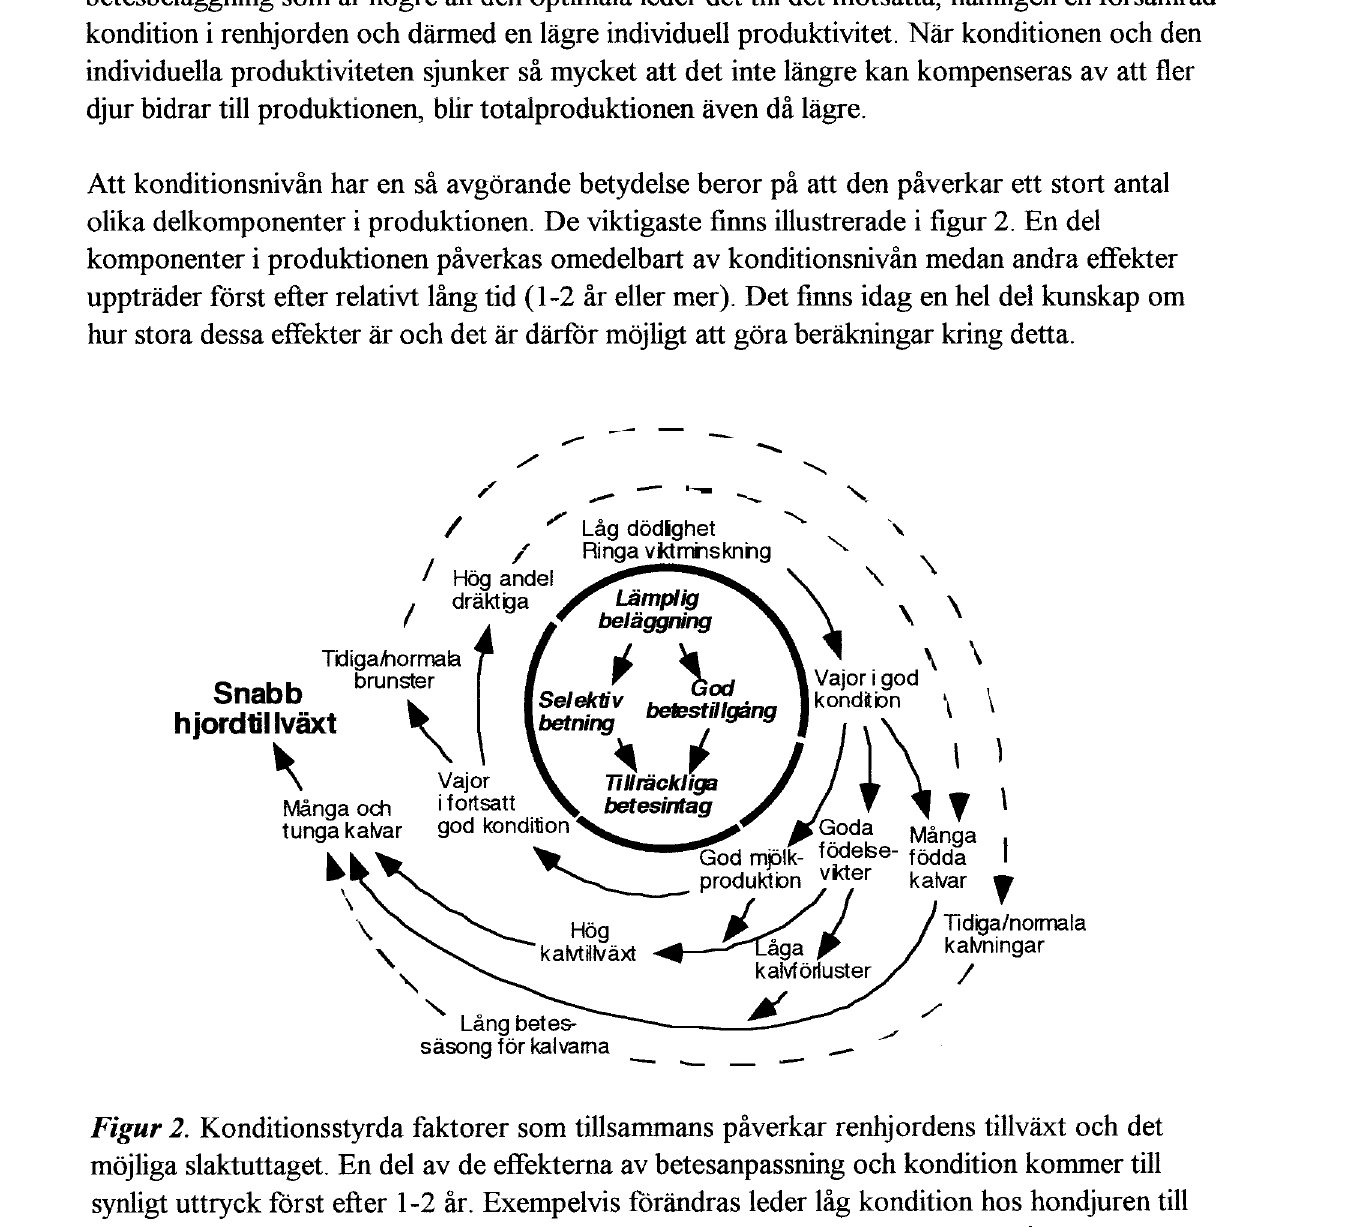
Figur 2. Konditionsstyrda faktorer som tillsammans påverkar renhjordens tillvåxt och det möjliga slaktuttaget. En del av de effekterna av betesanpassning och kondition kommer till synligt uttryck forst efter 1-2 år. Exempelvis förändras leder låg kondition hos hondjuren